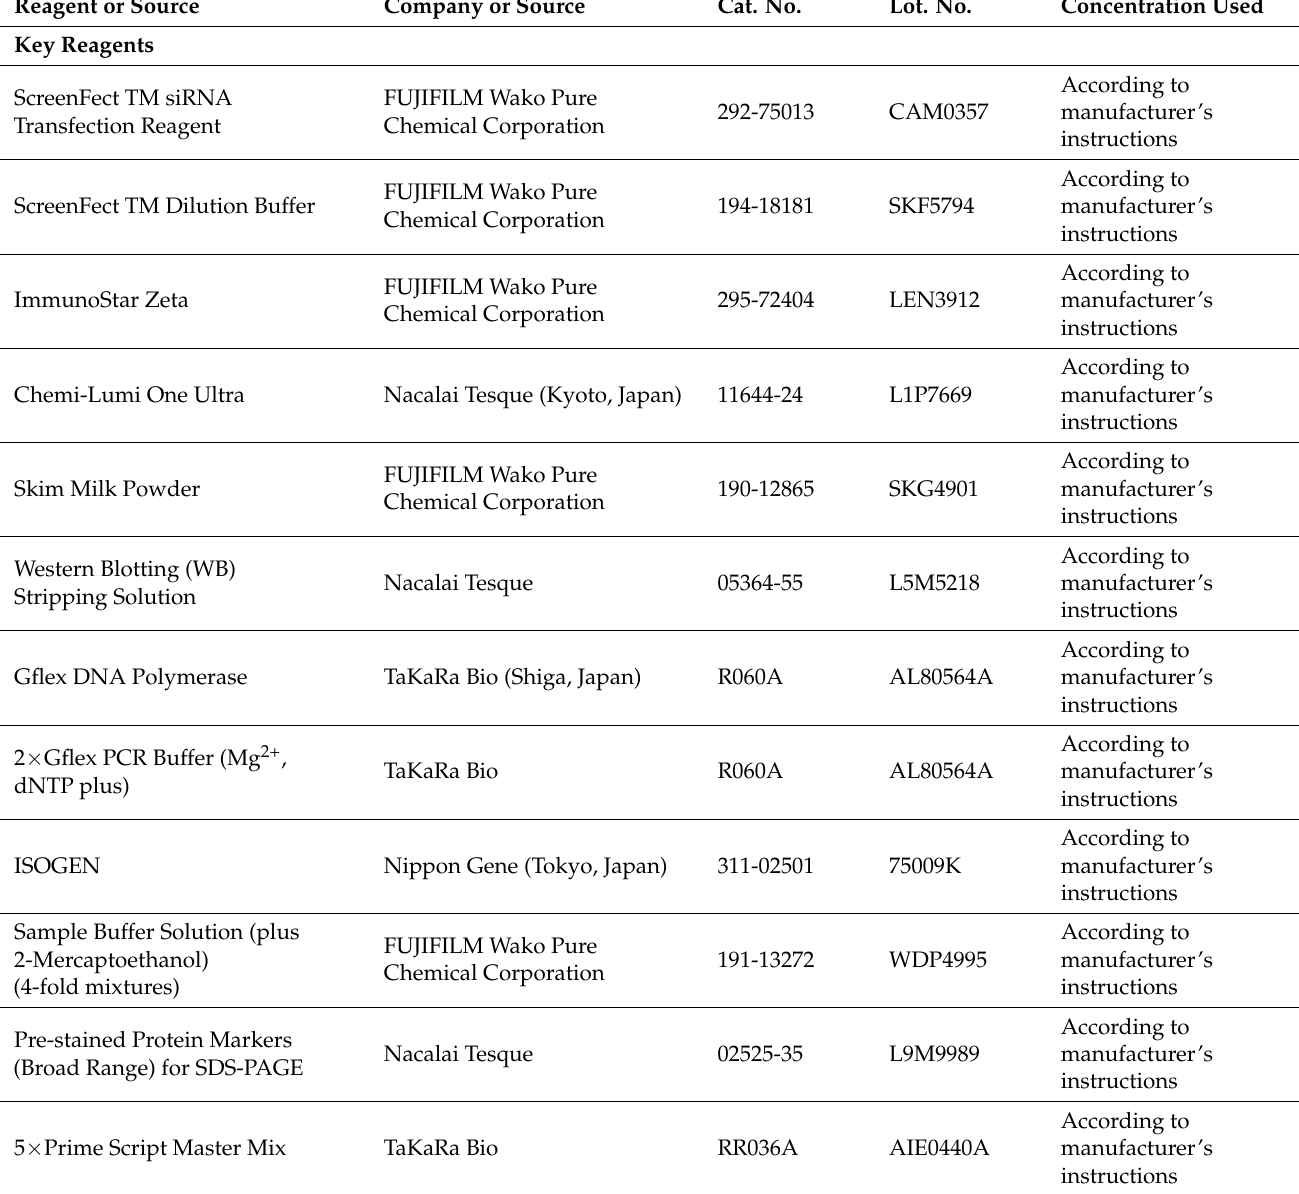
Table 3. List of